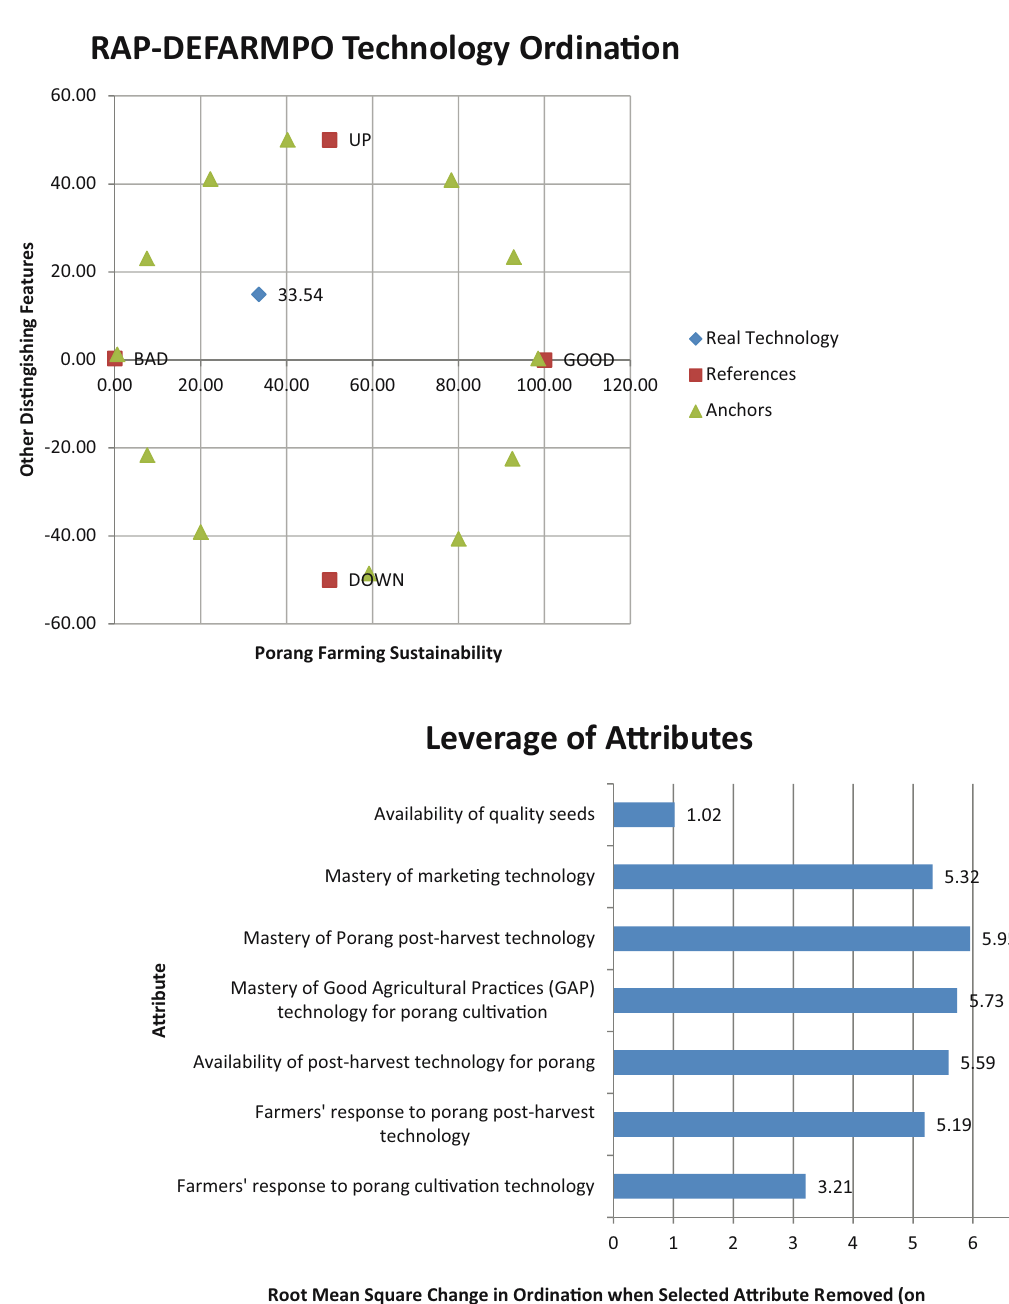
Figure 7: Dimensions of